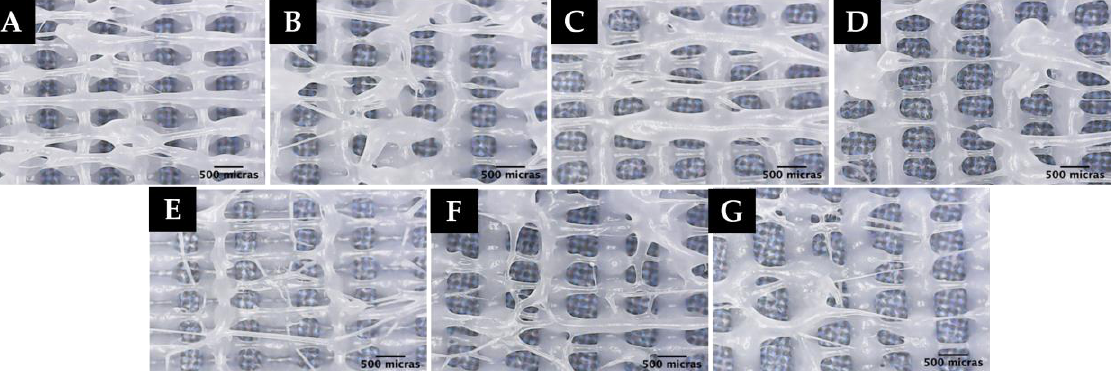
Figure 7. Microscopic images of experiment: ( A ) V1B, ( B ) V2B, ( C ) V3B, ( D ) V4B, ( E ) V5B, ( F ) V6B,